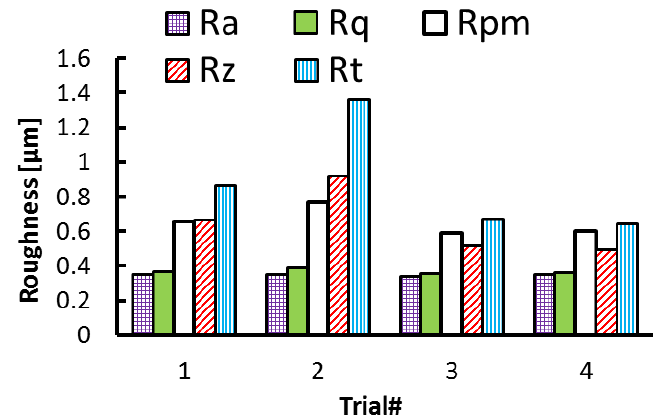
Figure 5. Effect of cutting conditions on the height roughness parameters in hoop